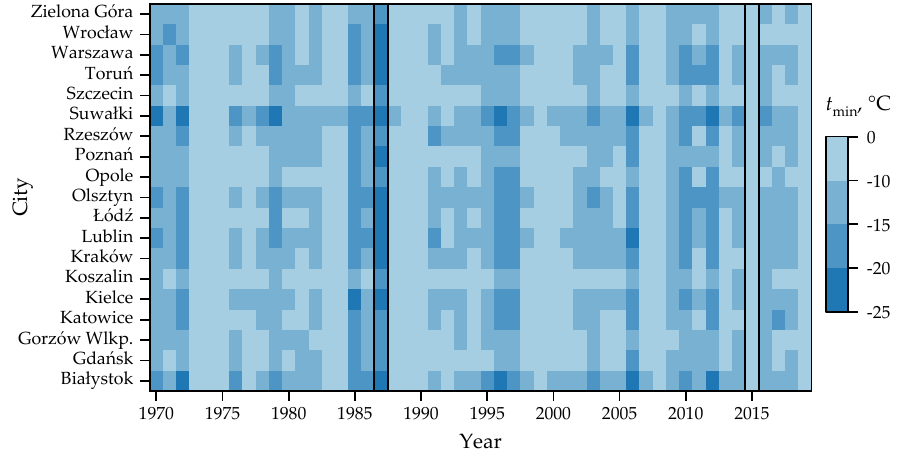
Figure 4. Minimum five-day temperatures ( t min , °C) recorded between 1970 and 2019.